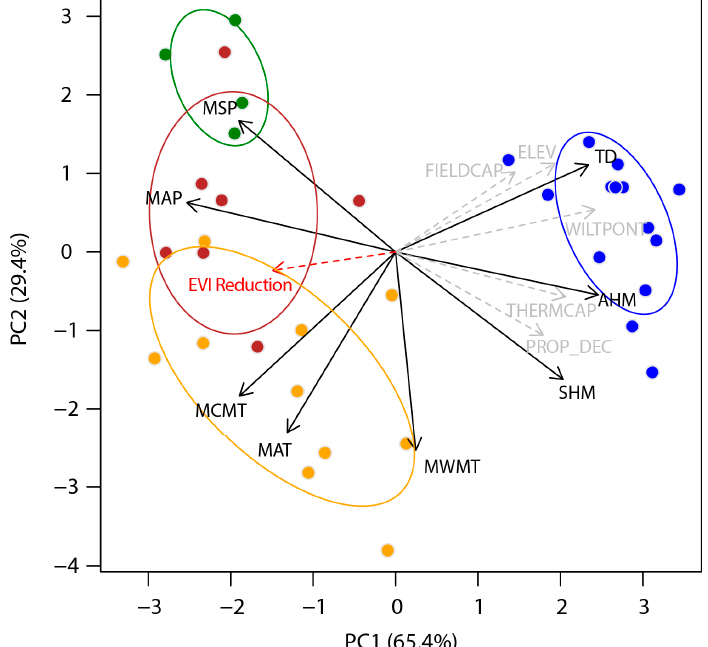
Figure 4. Principal component analysis of ecosystem attributes, and indirect gradient analysis associating the EVI decline during the heat wave (red vector). Climate variables are represented by black vectors and other ecosystem attributes by gray vectors. For abbreviation of variables, see Table 2. Ecosystem averages are represented by points, and ellipses delineate the 80th percentile of grid cells corresponding to the four regions shown in Figure 2. Table 2. Correlations among EVI reduction ( ∆ EVI), following the 2021 heat wave, and variables that may putatively contribute to ecosystem vulnerabilities, as well as variable averages by region, corresponding to the principal component analysis in Figure 4.